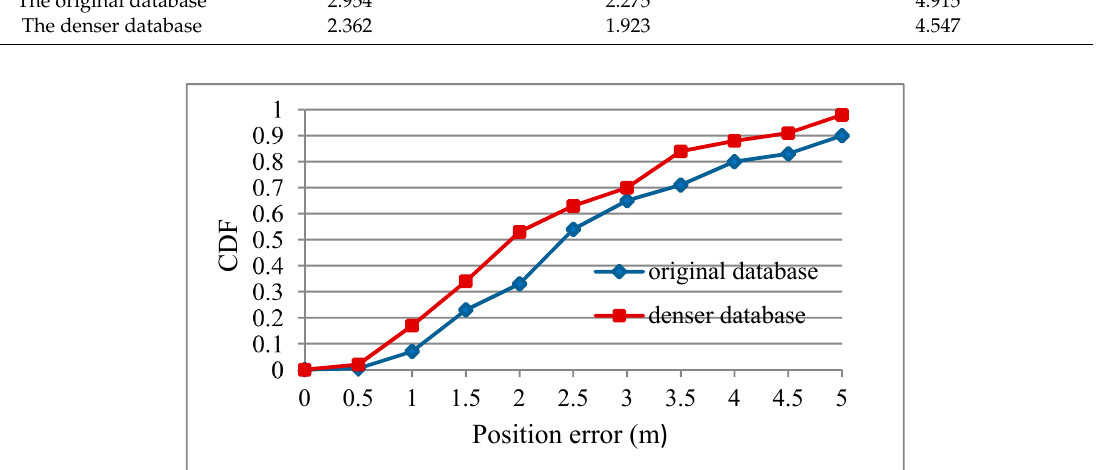
Figure 7. Cumulative distribution function (CDF) with different fingerprint databases.